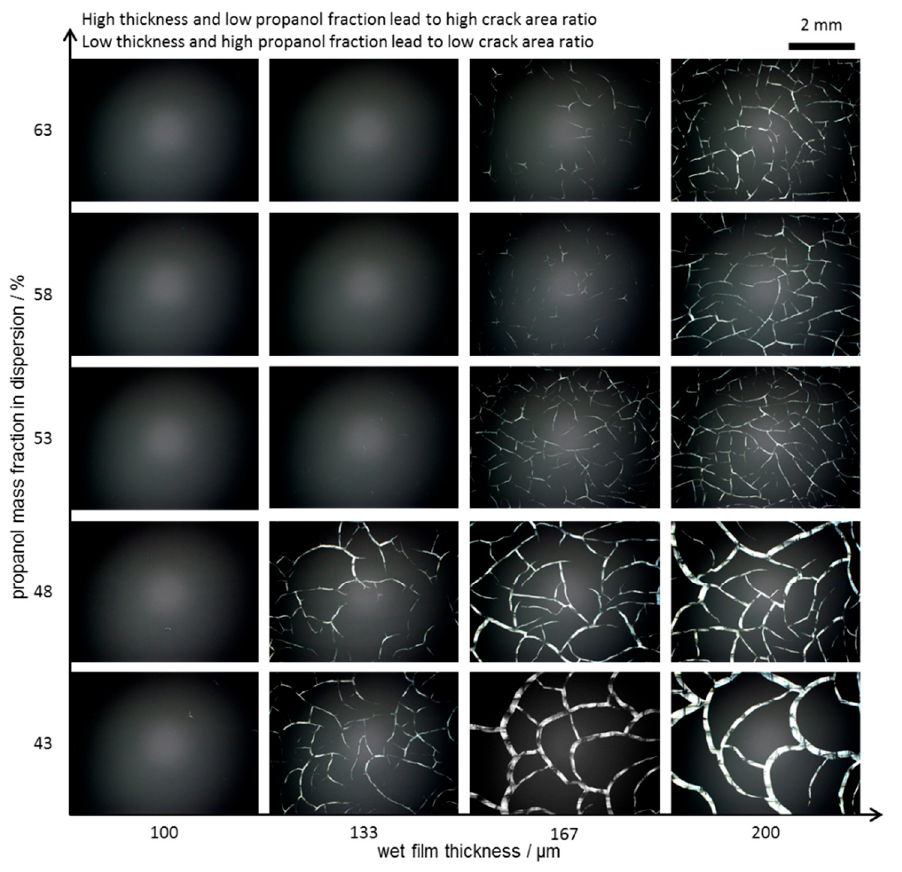
Figure 2. An overview of 20 layers generated from five different dispersions varying the wet layer thickness between 100 and 200 µm. The images were recorded by the microscope.